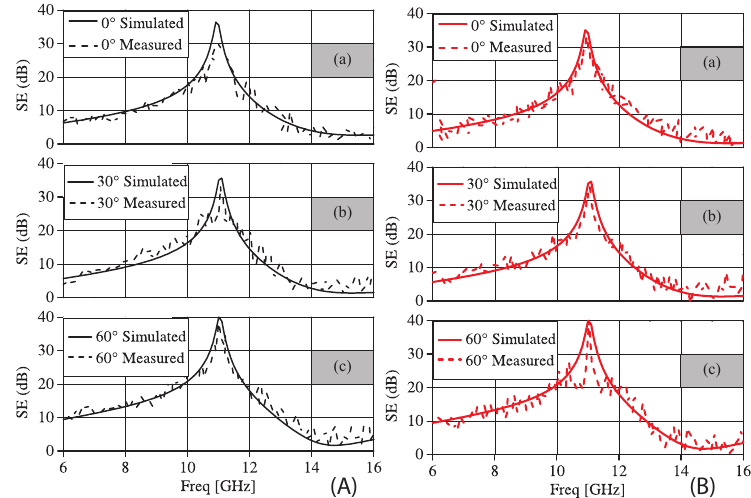
Figure 11. ( A ) Angular stability analysis of the proposed FSS for the TE/TM polarizations at ( a ) 0 ◦ , ( b ) 30 ◦ , and ( c ) 60 ◦ . ( B ) Angular stability analysis for the 45 ◦ polarization at ( a ) 0 ◦ , ( b ) 30 ◦ , and ( c ) 60 ◦ .